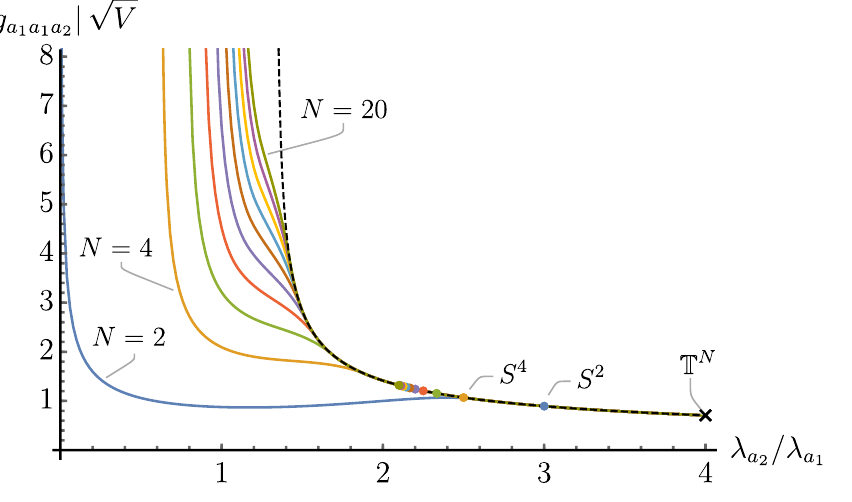
jp V as we vary (cid:21) a =(cid:21) a for closed Einstein manifolds with 1 a 1 a 2 2 1 (cid:21) (cid:21) a , and (cid:21) + (cid:21) (cid:21) a . The cross again a a 1 2 =(cid:21) a (cid:0) 4) (cid:0) 1 = 2 , which the 2 1 =(cid:21) a (cid:20) 2 1